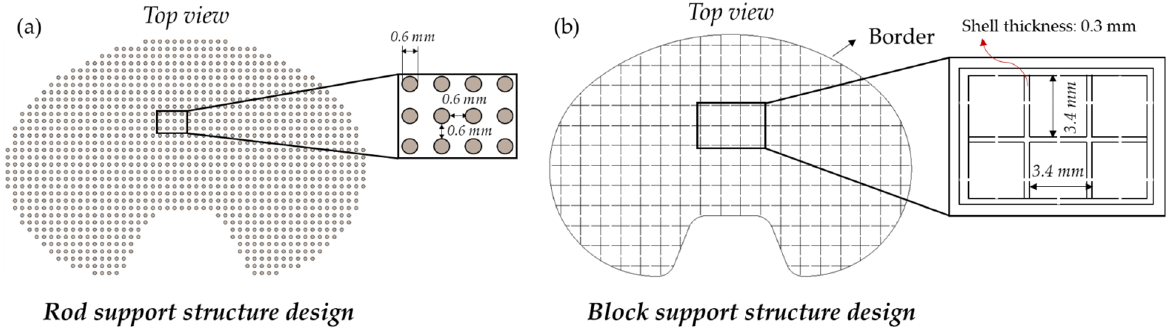
Figure 5. The pattern and dimensions of support structure: ( a ) Rod support-structure design; ( b ) Block support-structure design.